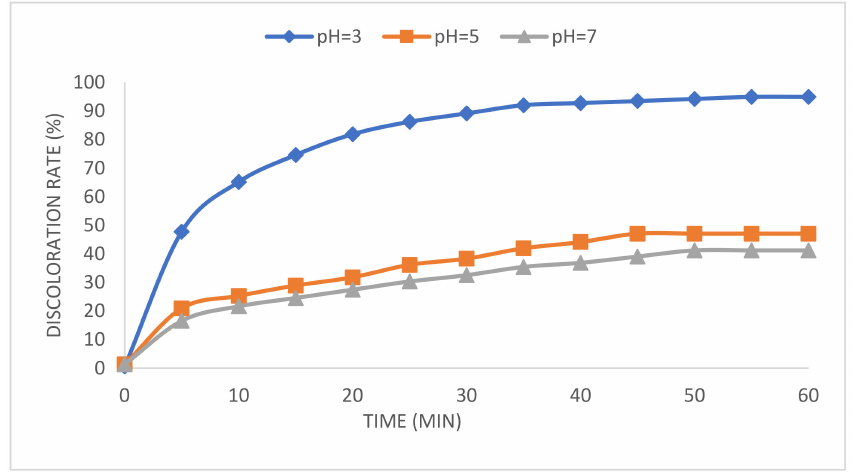
Figure 2. Effect of initial pH on the rate of discoloration. Reaction condition: [MO] = 20 mg/L 50 mM Na 2 SO 4 , [I C ] = 100 mA, 0.2 mM Fe 2+ , 8.8 mM H 2 O 2 , and T = 30 ± 0.1 ◦